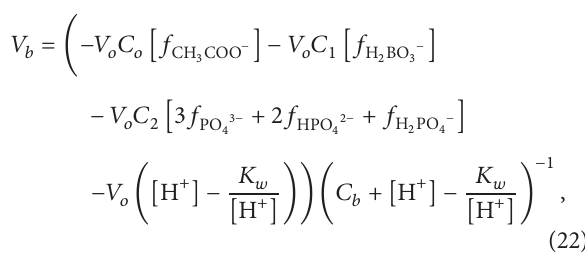
Figure5:Plotsof 𝜅 and 𝜅 conductivity are different because of the large dilution during titration. (b) Experimental plots 𝜅 (18) and (3) (solid line), and its first derivative, 𝑑𝜅